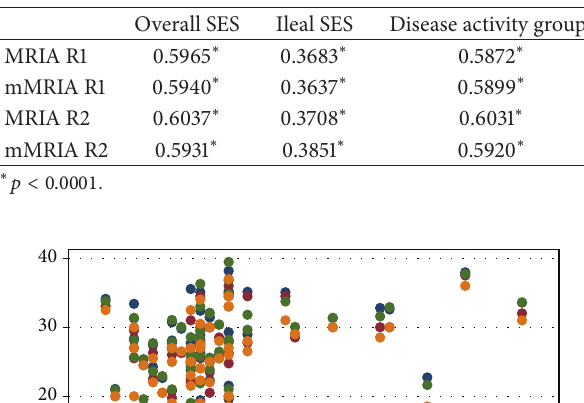
Table 4: Correlation coefficients between MRIA, mMRIA, and endoscopic findings for R1 and R2.